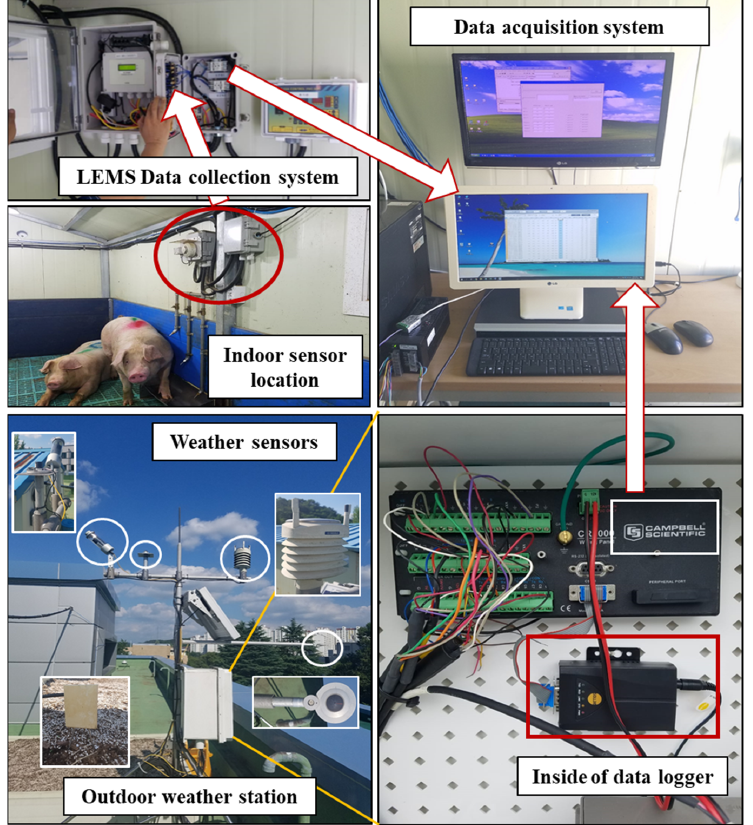
Figure 2. Devices used for data acquisition of indoor (LEMS) and outdoor (Campbell scientific weather station) including sensor extensions; data transmission process during LEMS and CR1000X data storage to the primary